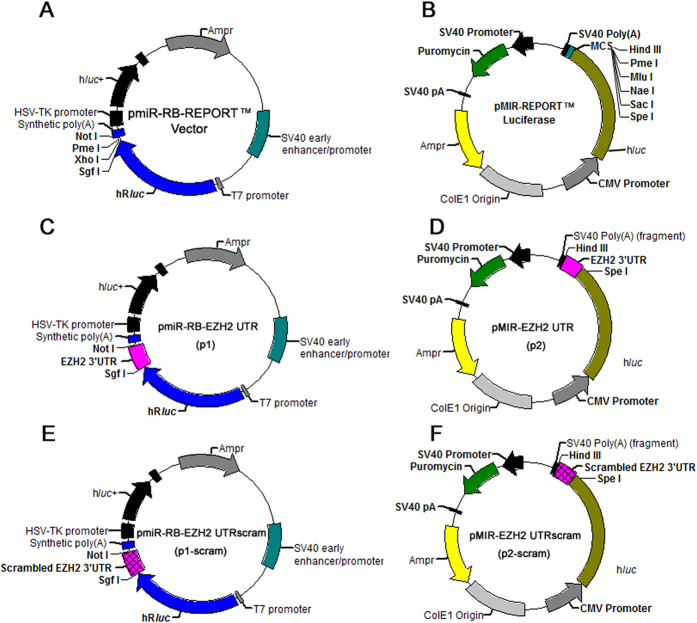
Luciferase reporter vectors.Abbreviations: Ampr, ampicillin resistance gene; hluc+ or hluc, firefly luciferase gene; hRluc, renilla luciferase gene; SV40 early enhancer/promoter, simian vacuolating virus 40 early enhancer/promoter; CMV Promoter, human cytomegalovirus immediate-early promoter.